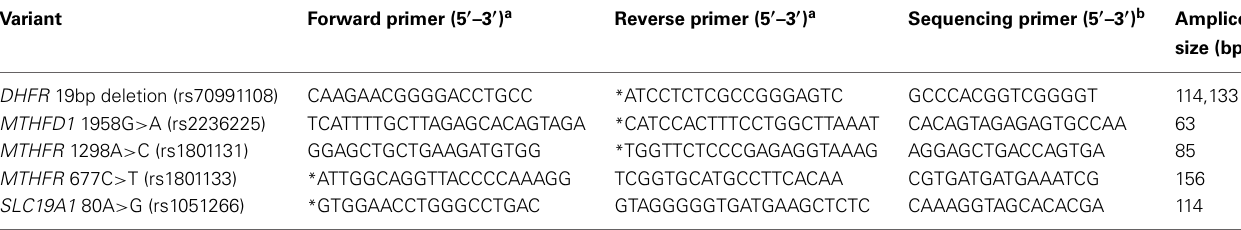
Table 1 | Primer sequences and PCR amplicon size for DHFR , MTHFD1 , MTHFR , and SLC19A1 variant analysis.